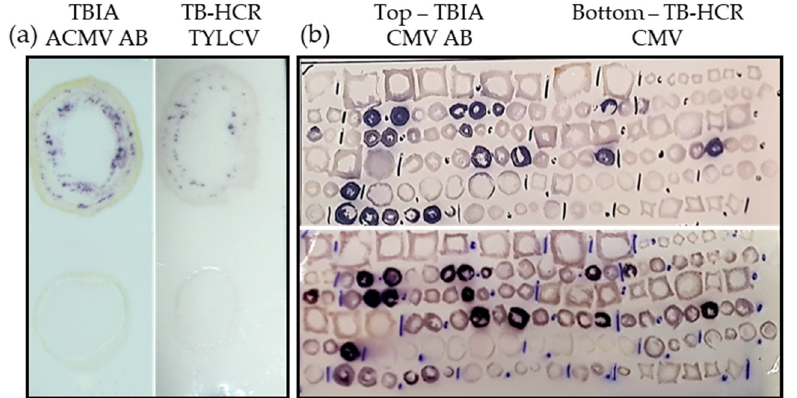
Figure 7. The comparison of TB-HCR with TBIA. ( a ) TYLCV positive and negative blots were processed with ACMV McAb (TBIA) or probed with TYLCV-P1, -P3, and -P4 (TB-HCR). TYLCV positive blots showed small purple spots in the phloem region of the blot. ( b ) A large, replicated survey blot was processed with anti-CMV rabbit polyclonal antibody (Agdia) or probed with the six CMV-SG probes. CMV positive plant blots stained dark